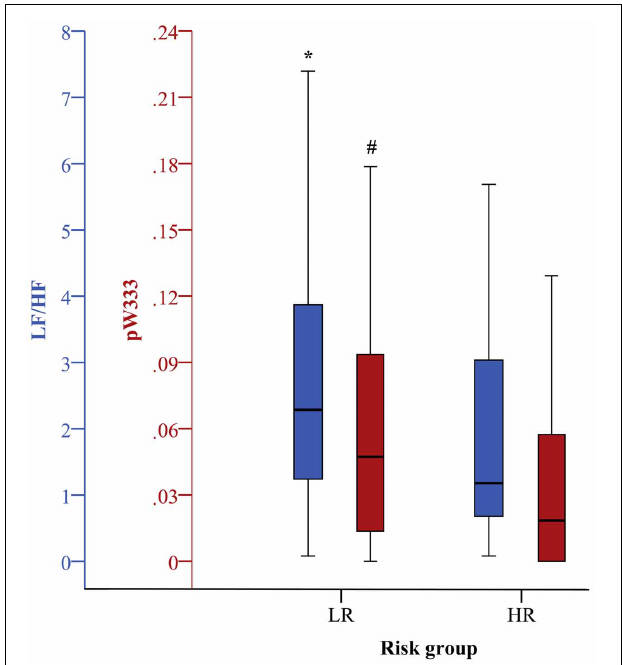
FIGURE 3 | Boxplots of the most significant univariate clinical, linear, and nonlinear indices (30min day phase) discriminating low (LR) and high (HR) risk groups ( # p < 0 . 01; † p < 0 . 001).